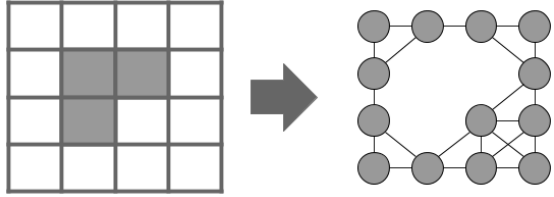
Figure 1. Undirected graph representation of a 2D occupancy